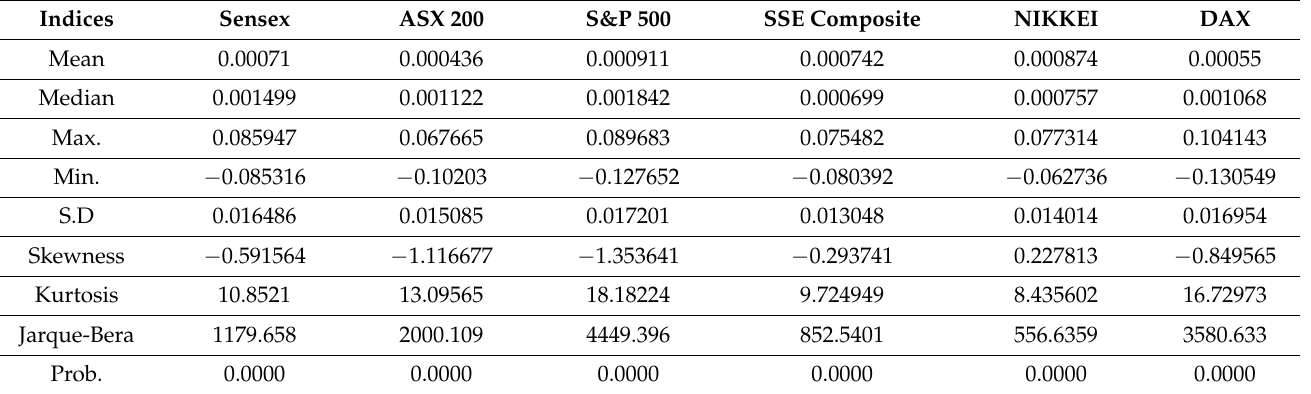
Table 2. Descriptive Statistics.